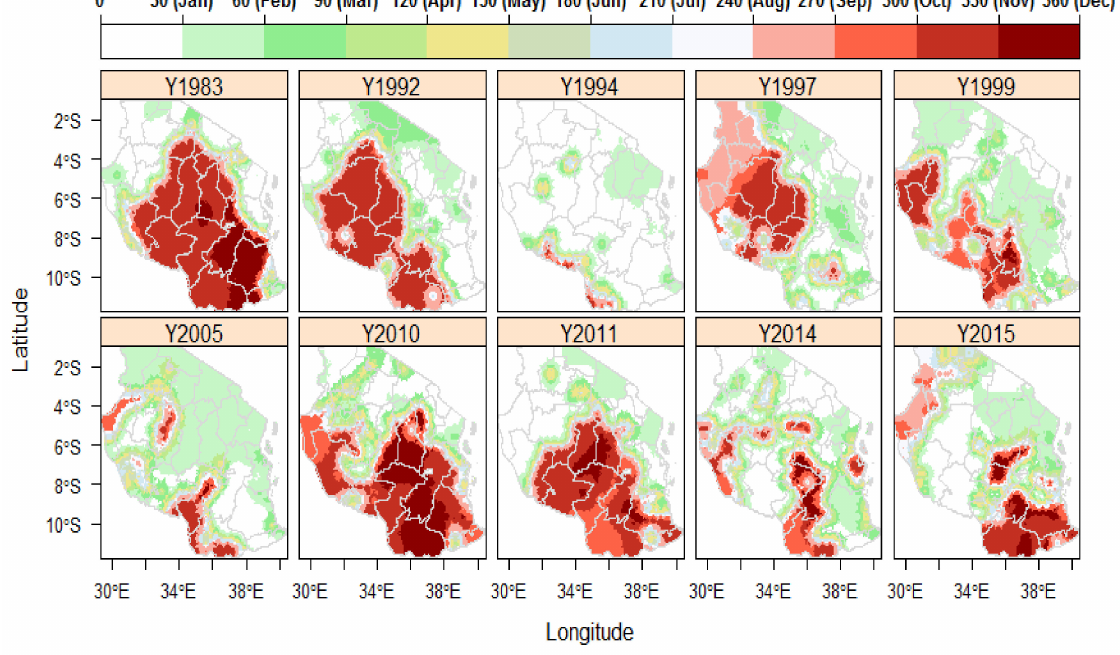
Figure 6. Starting date of heatwave events of Figure